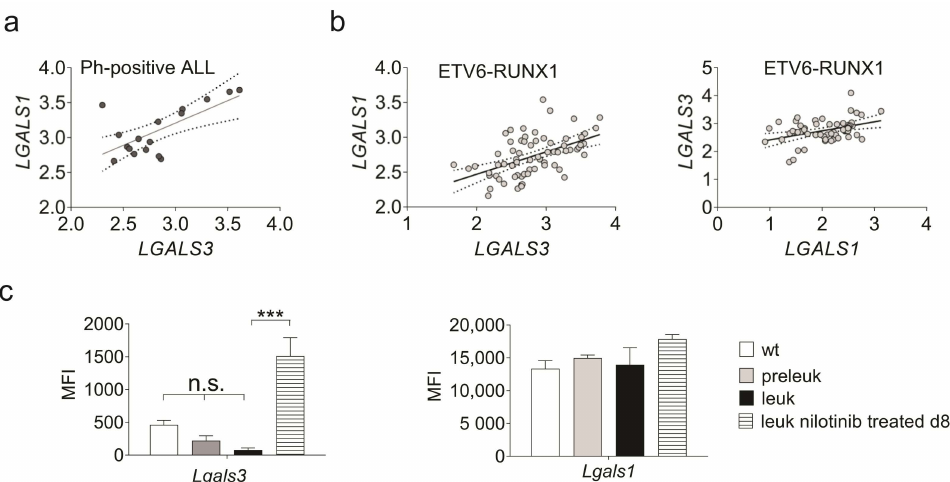
Figure 1. LGALS1 and LGALS3 mRNAs are co-expressed in human and mouse BCP-ALL cells. Positive correlation between log10 LGALS1 and LGALS3 mRNA expression in ( a ) human Ph-positive ALL samples (GSE79533) and ( b ) ETV6-RUNX1 ALL samples in two different arrays (left, GSE79533; right, GSE28497). Pearson correlation analysis, where dotted lines indicate the 95% confidence range of the best fit line. ( c ) Meta-analysis of GSE110104 for Galectin-3 ( Lgals3 ) and Galectin-1 ( Lgals1 ) gene expression in mouse B-cell precursor cells, flow sorted from bone marrows of control wild-type (wt) mice and pre-leukemic; fully leukemic (leuk); and leukemic, 75 mg/kg/d d8 nilotinib-treated BCR/ABL P190 transgenic mice. Each set consists of three biological replicates. *** p < 0.001. One-way ANOVA, Tukey’s multiple comparisons test. Right panel, no significant differences. MFI, mean fluorescent